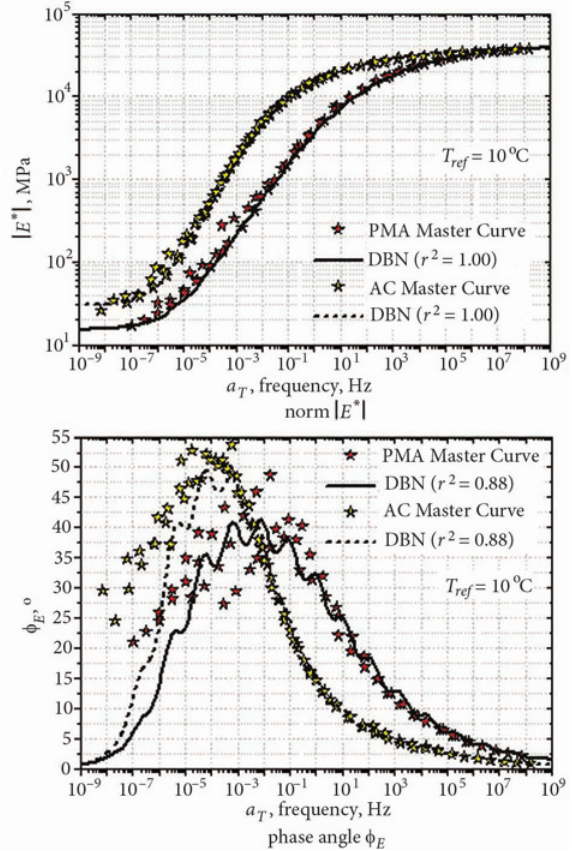
fig. 2. Experimental master curves and DBN model simulation (20 elements) for complex Young’s modulus E * of the two bituminous materials (PMA and AC) plotted at a reference temperature T ref = 10 °C